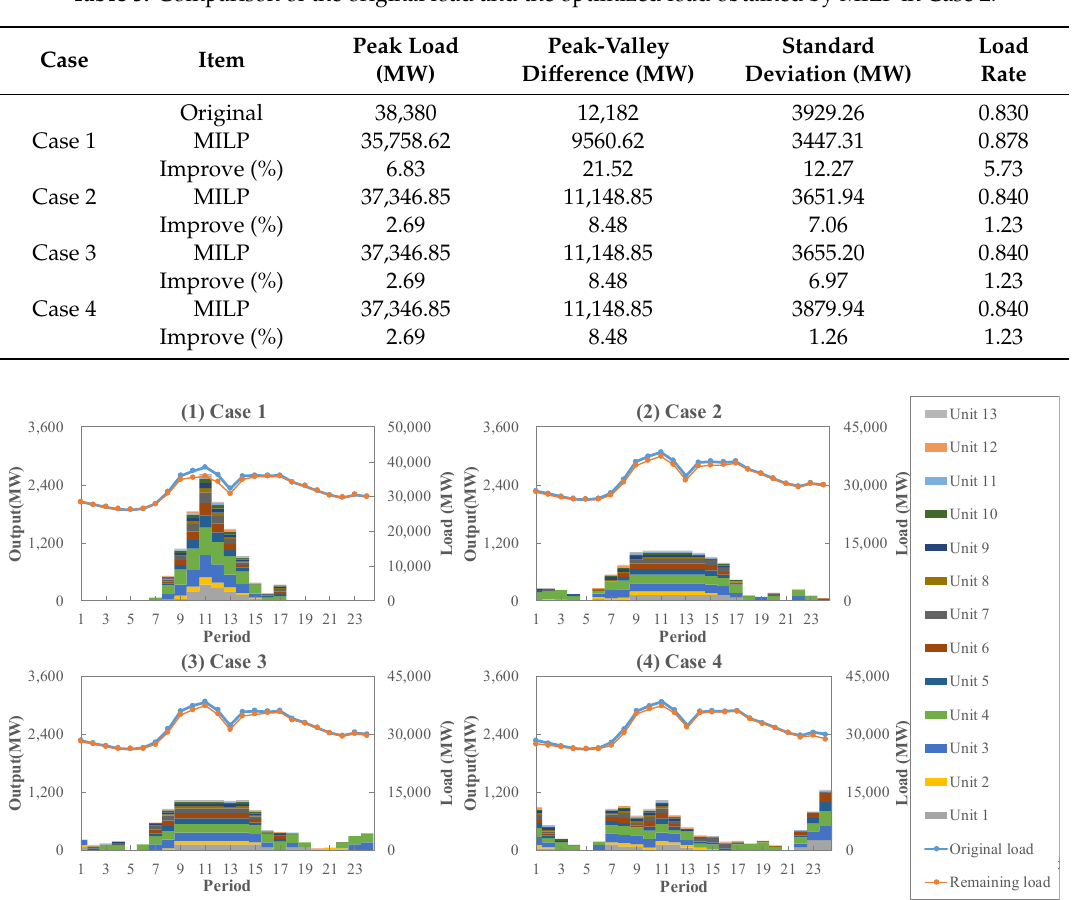
Table 6. Comparison of the original load and the optimized load obtained by MILP in Case 3.